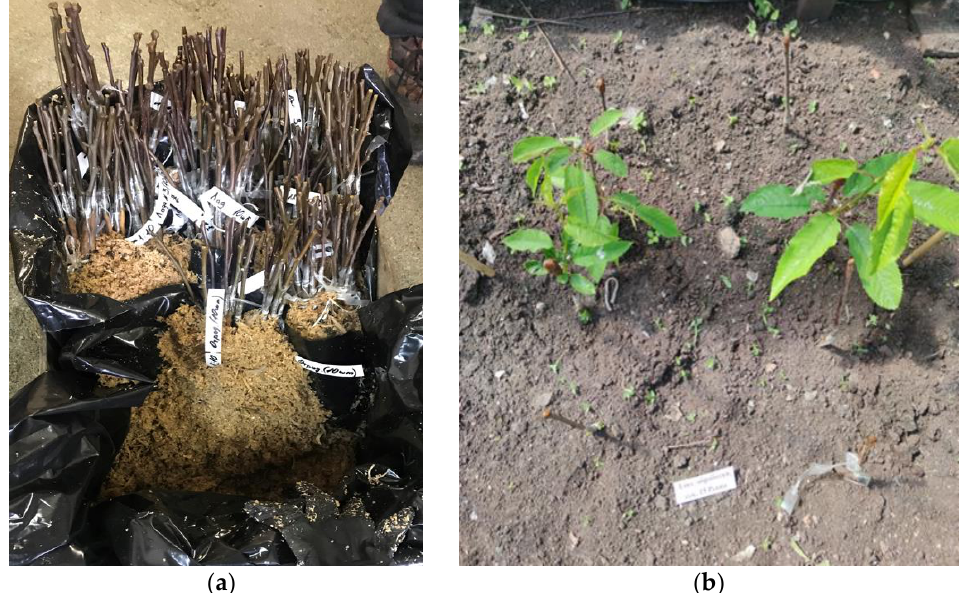
Figure 3. Processed and grafted cuttings of the sweet cherry variety “Revna”: ( a ) before being placed in storage for 2 months with an air temperature of 1 – 2 °С; ( b ) planted in a greenhouse at 30 – 35 °C after being removed from storage, as of 06/08/21.